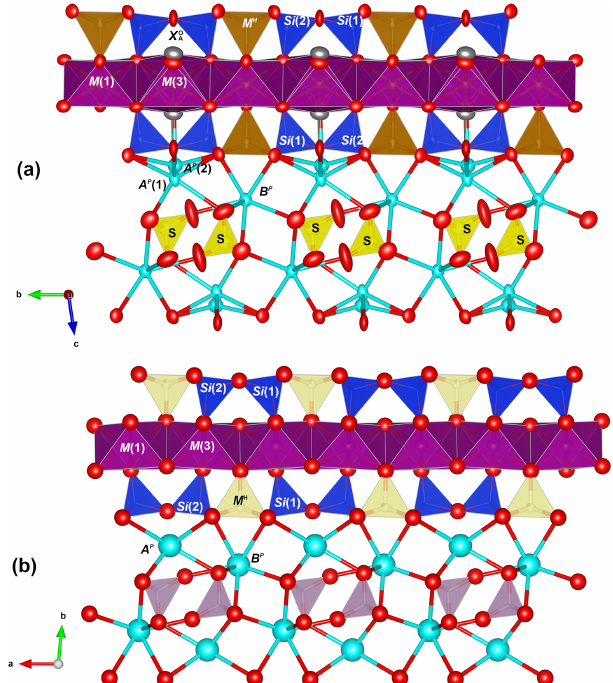
Figure 6. The crystal structures of zinkgruvanite (a) and yoshimu- raite (b) (McDonald et al., 2000) for comparison. Mn 2 + octa- hedra: purple; Fe 3 + O 5 pyramid: light brown; Ti 4 + O 5 pyramid: cyan; SiO 4 tetrahedra: blue; SO 4 tetrahedra: yellow; PO 4 tetrahe- dra: pink, Ba 2 + cations: cyan; oxygen anions: red; chlorine anions: grey. Obtained with Vesta 3 (Momma and Izumi,